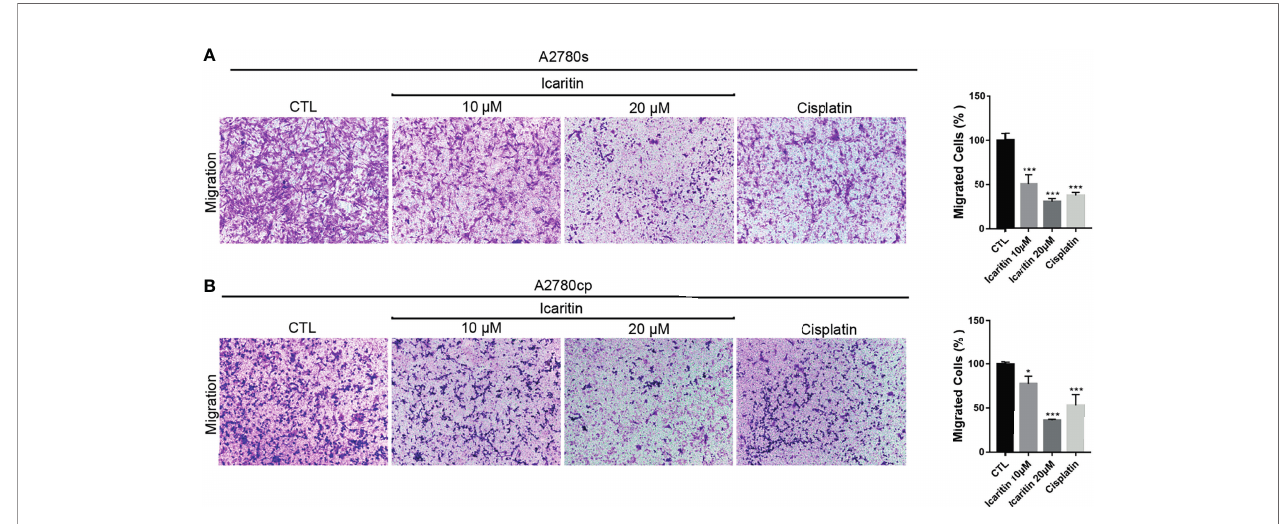
FIGURE 3 | Icaritin suppresses the migration of ovarian cancer (OC) cells. (A) A2780s were treated with icaritin (20 m M) or cisplatin (1.6 m g/ml) for 12 h. Representative images and quanti fi cation of the migrated cells are shown. Data are represented as means ± SEM. *** p < 0.001 by 2-tailed Student ’ s t -test.